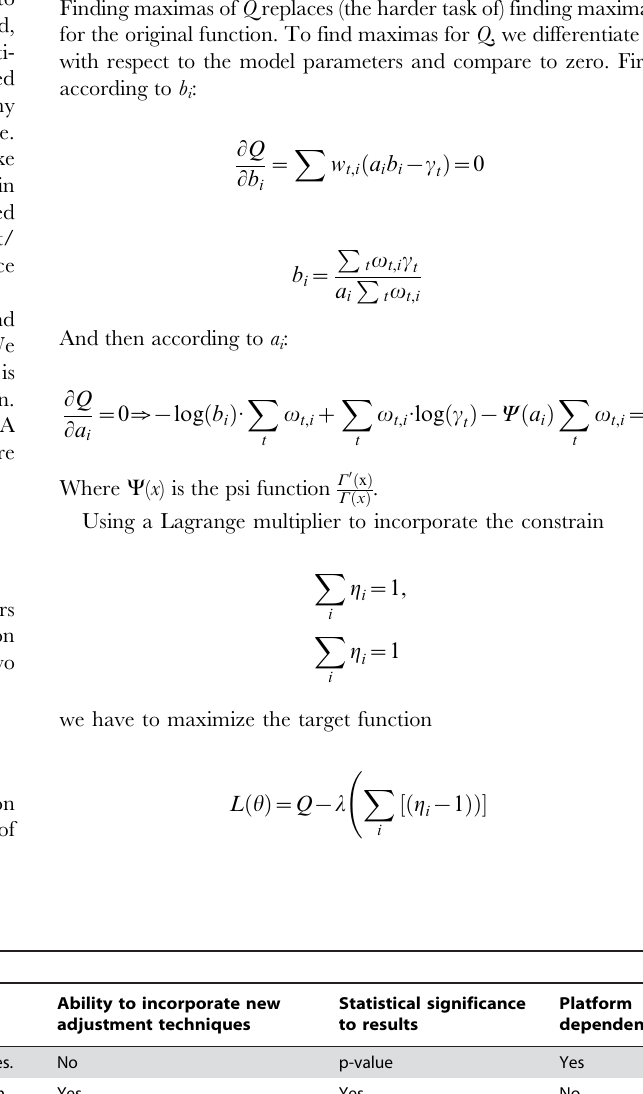
Technique Potential use